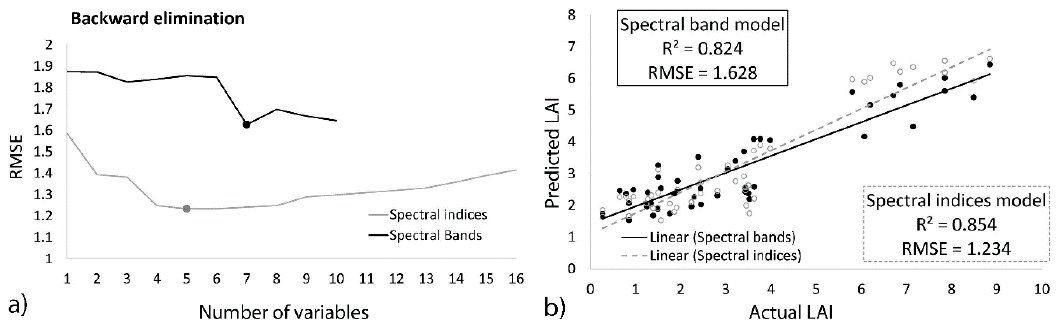
Figure 4. ( a ) The optimal predictive variable selection using the backward elimination process. ( b ) Relationships between the predictive and actual LAI values, using the best spectral bands and spectral indices model. Points represent measurements at the ESU level, dashed lines represent a 1:1 relationship.